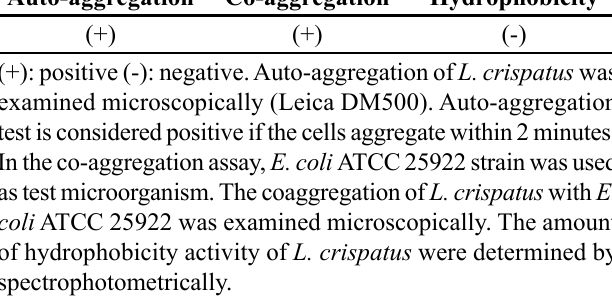
TABLE II - The auto-aggregation, co-aggregation and hydrophobicity activities of the L. crispatus